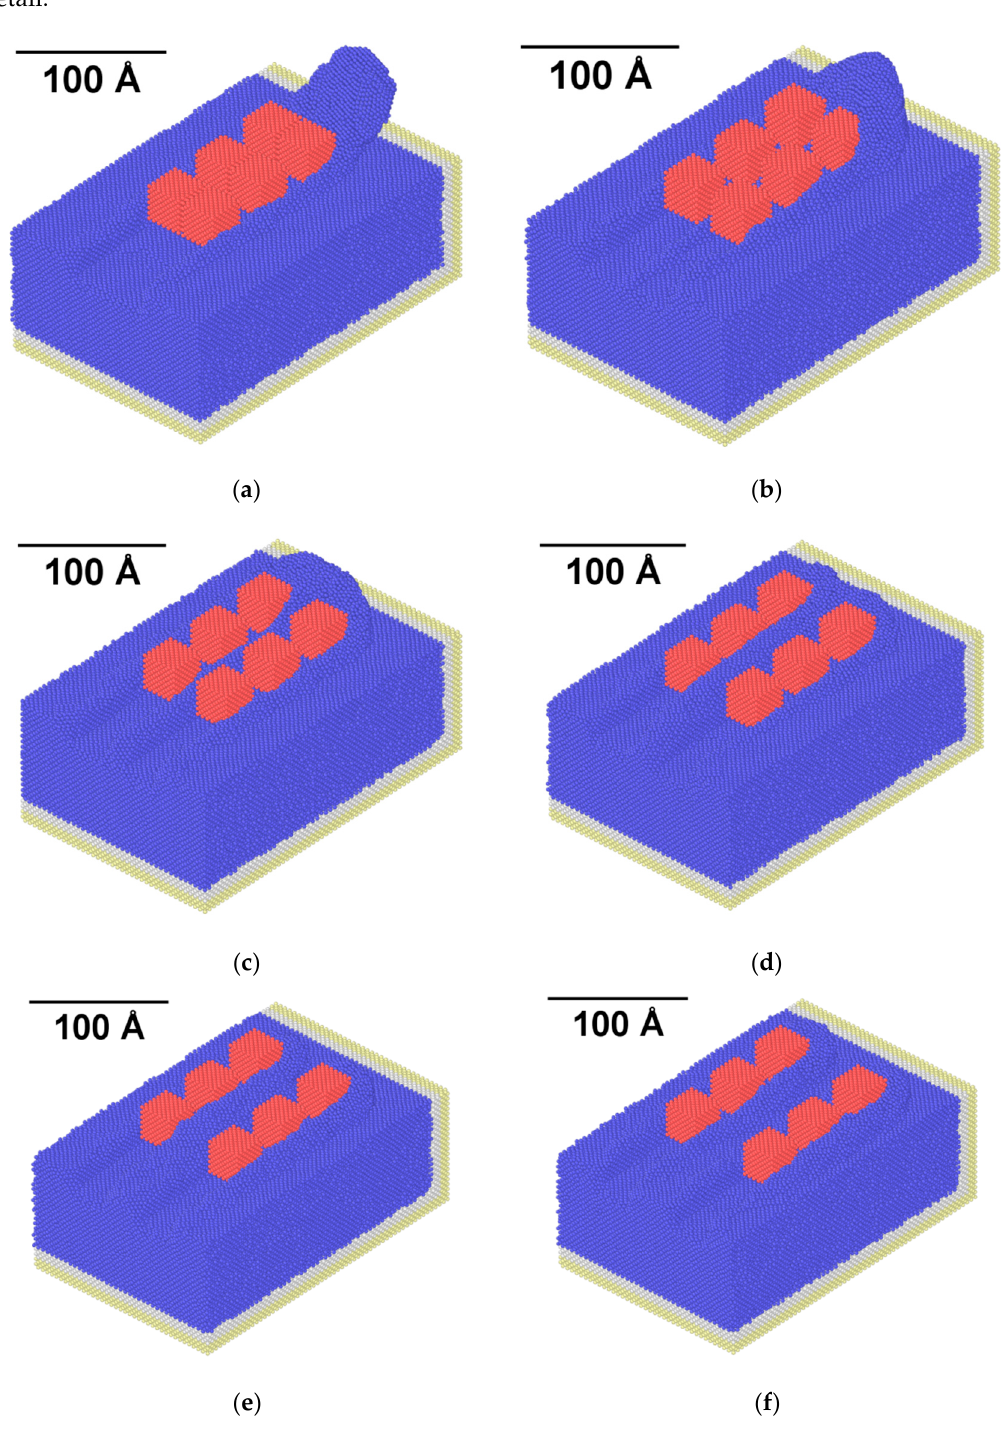
Figure 2. Snapshots of nanogrinding at the final timestep for the cases with spacing values of: ( a ) 1a, ( b ) 3a, ( c ) 5a, ( d ) 7a, ( e ) 9a, and ( f ) 11a.